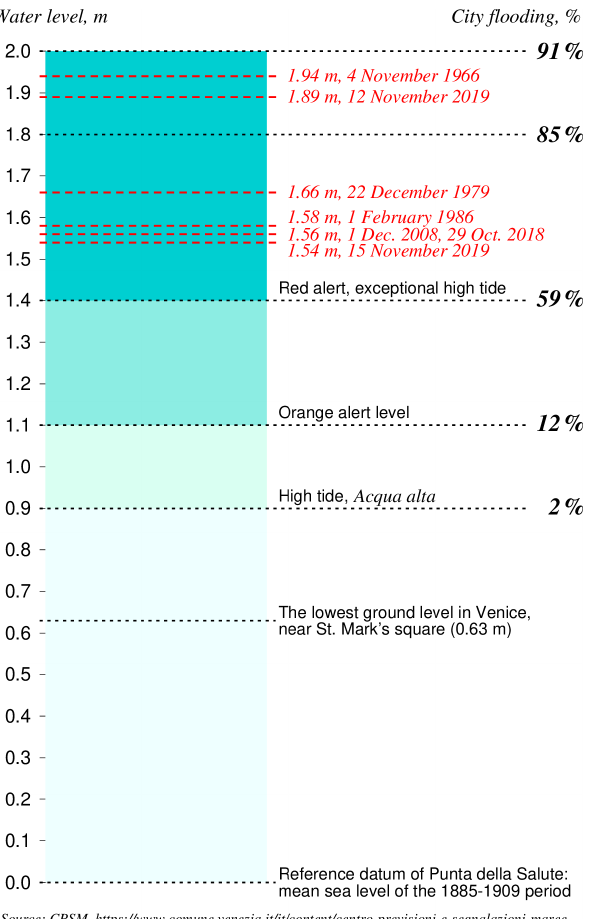
Figure 2. The local datum of Venice, the height of the lowest pave- ment level, the flooding percentages, definition of various alert lev- els and the height of important historic floods. Please note that the mean sea level of the last 10 years is approx. 32cm above datum. Therefore, at spring tide the water level reaches values of over 80cm without any meteorological